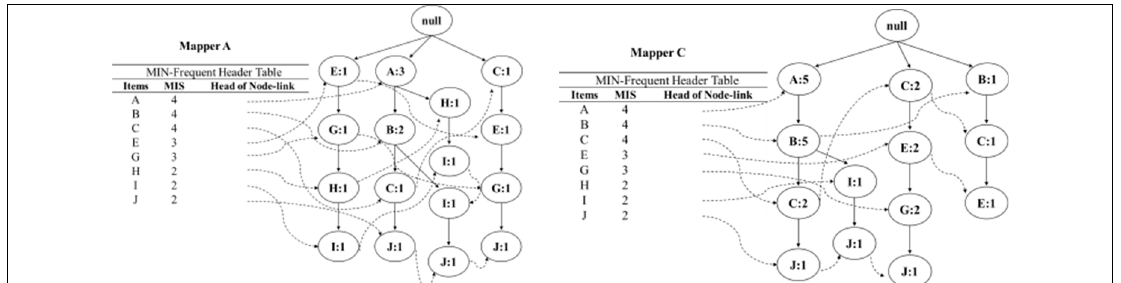
Figure 4. MISFP-tree with new data groups in different mapper nodes.